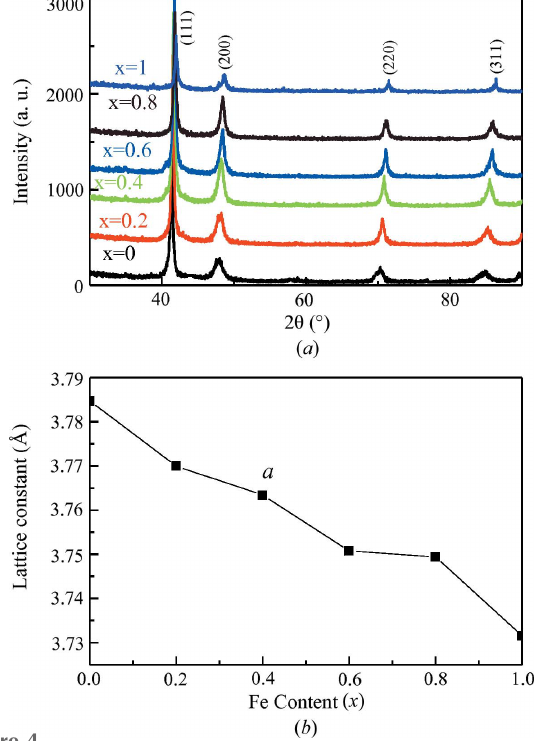
Figure 4 ( a ) XRD spectra measured at room temperature for Mn 3 (cid:2) x Fe x Ga samples heat treated at 1073 K; ( b ) effects of Fe substitution with Mn on the lattice